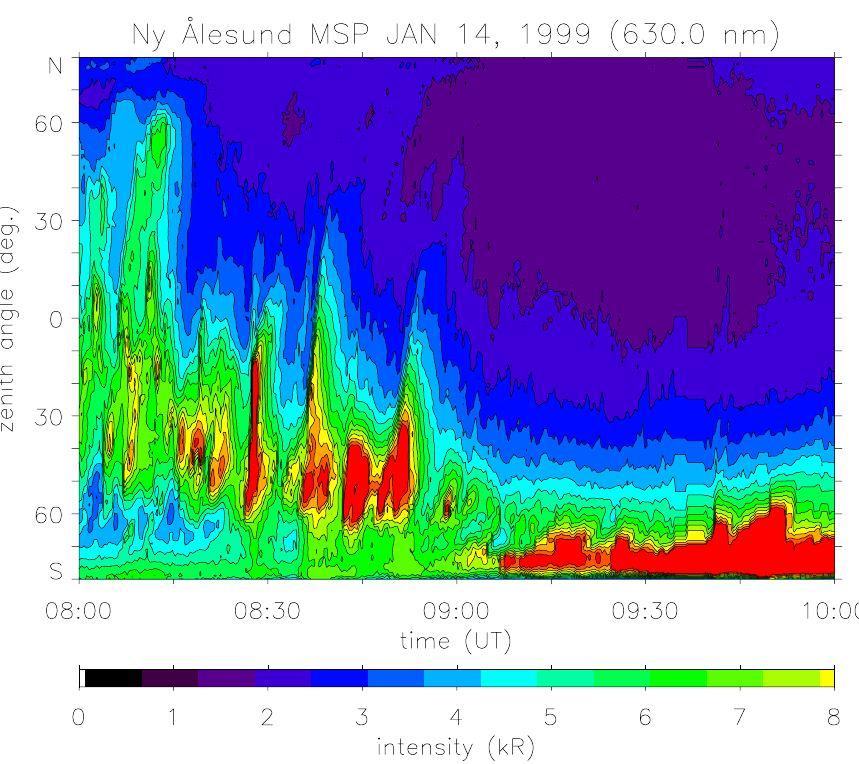
Fig. 4. Meridian scanning photometer line of sight intensities versus zenith angle, at 630.0nm, for the interval 08:00–10:00UT on 14 January 1999. Intensities are colour-coded according to the scale at the bottom.